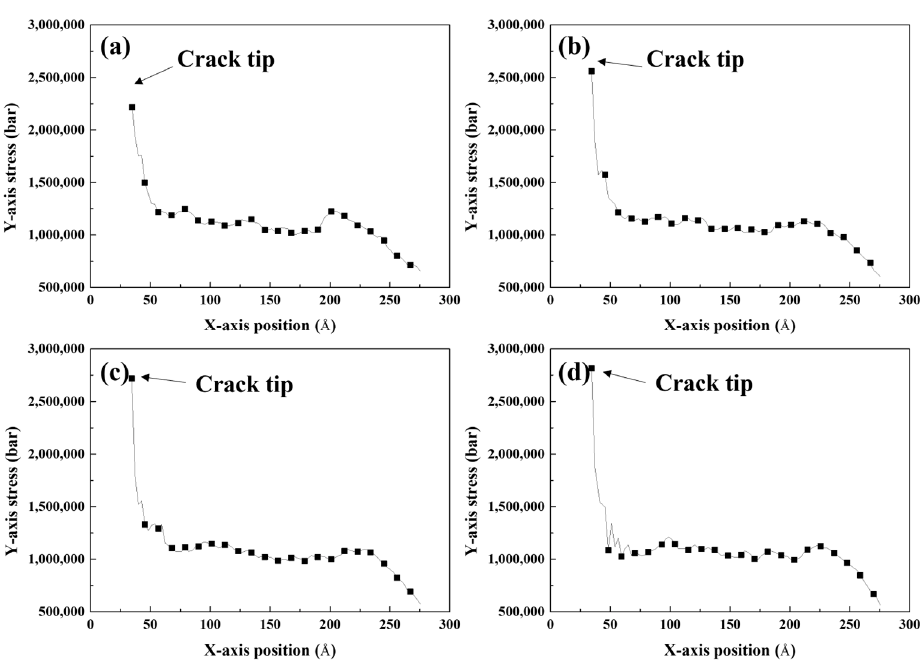
Figure 8. Average y-axis normal stress of the cracked Al containing an Mg–Si cluster with the radius of ( a ) 4, ( b ) 6, ( c ) 8, and ( d ) 9 Å as a function of the x-axis position (parallel to the crack direction). The atoms involved in this calculation were positioned along the crack direction (the region demarcated by the dotted box in Figure 7). Each calculation was conducted at the crack-opening